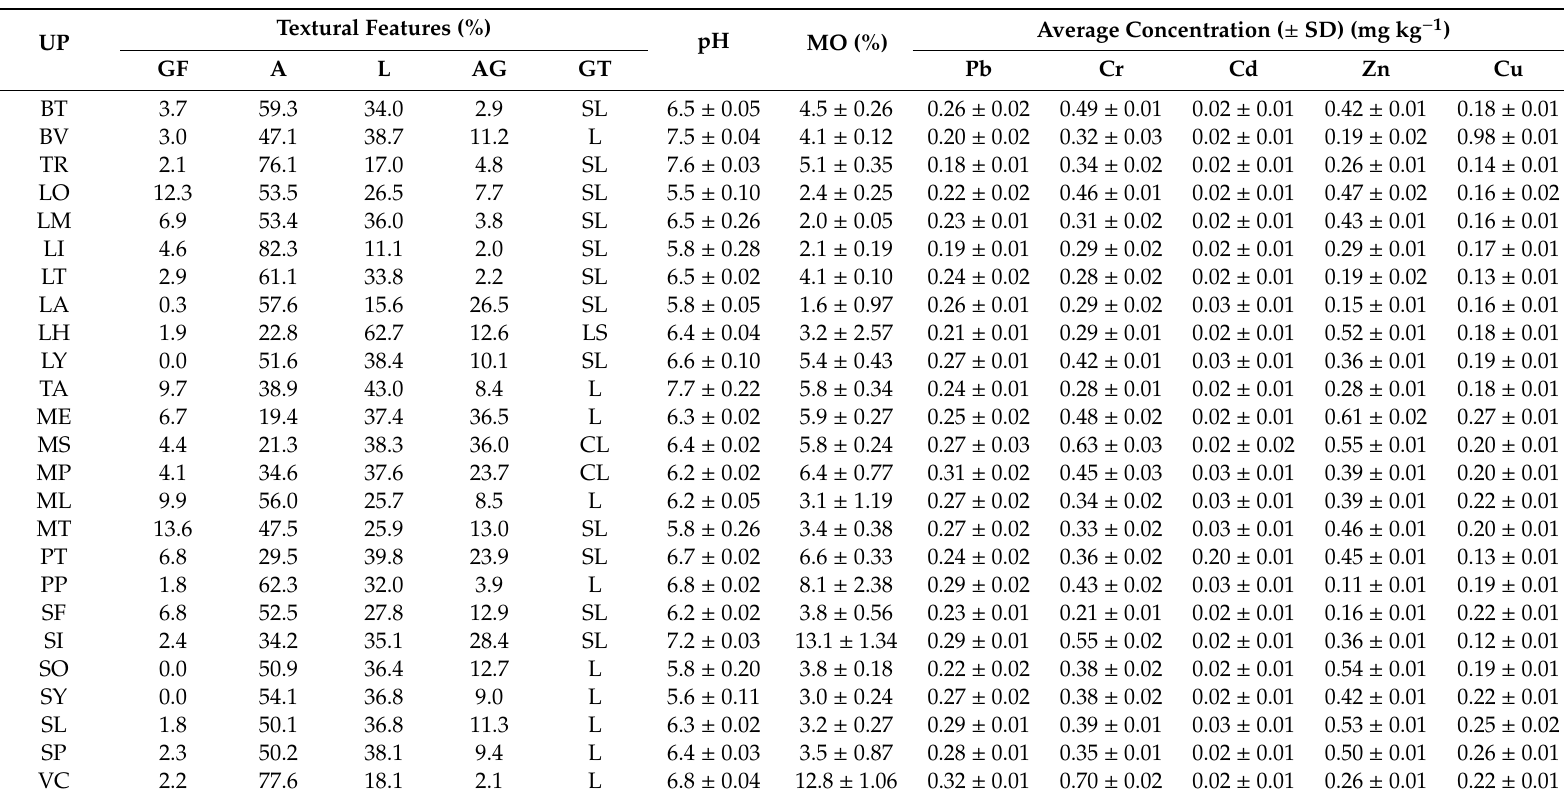
Table 1. Values of soil texture, pH, organic matter (MO), and heavy metal concentration in the study area of the Sotavento